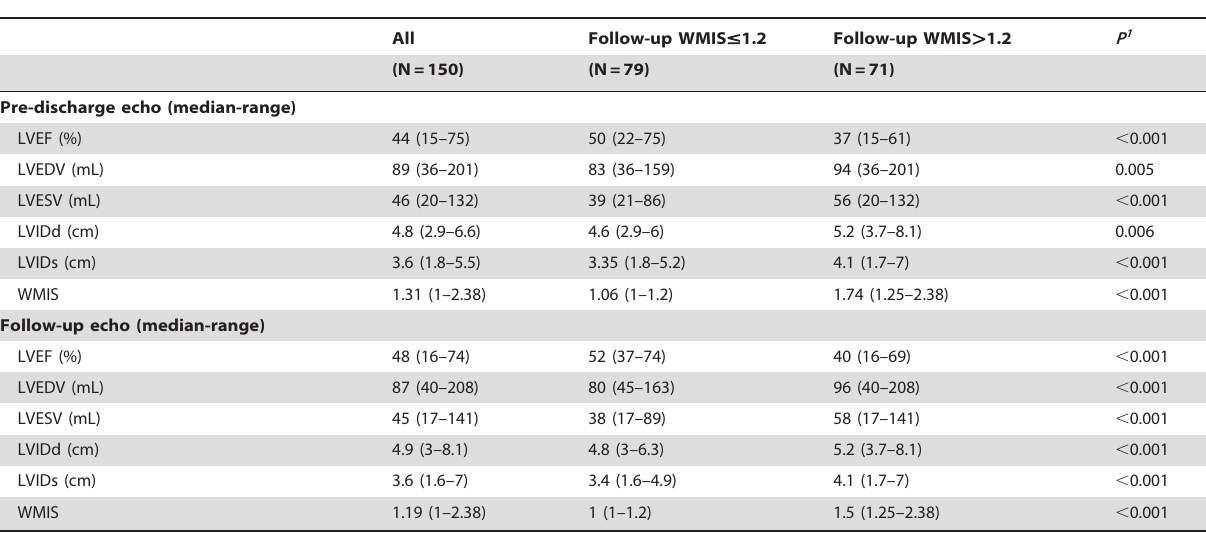
Table 2. Echo parameters of AMI